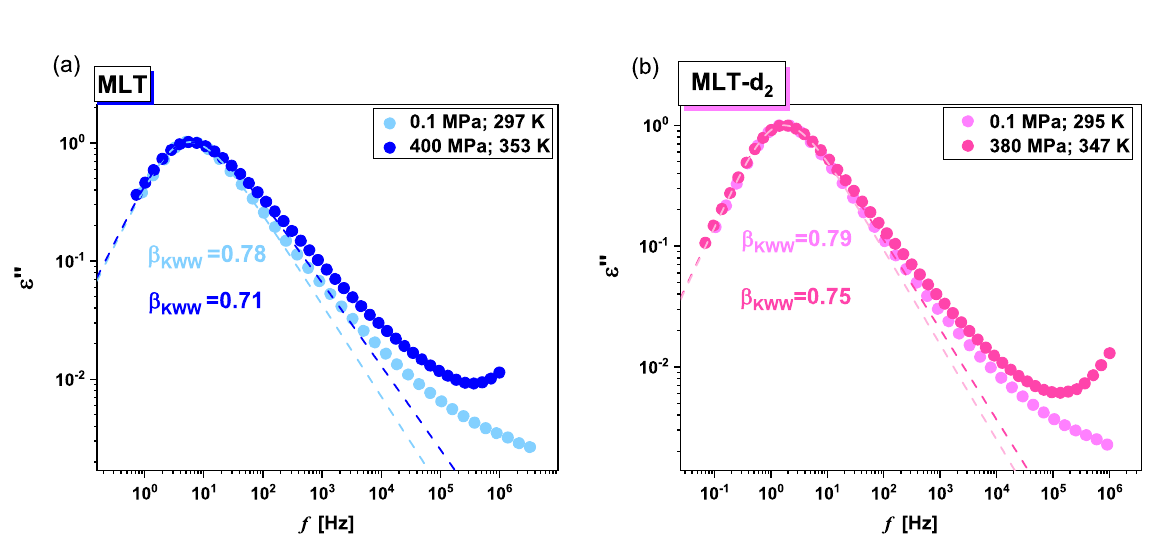
Figure 7. A comparison of dielectric spectra obtained at different thermodynamic conditions ( T , p ), close to T g for MLT ( a ) and MLT-d 2 ( b ). They were normalized with respect to the maximum of dielectric loss ( ε ” max ). The dashed lines represent KWW